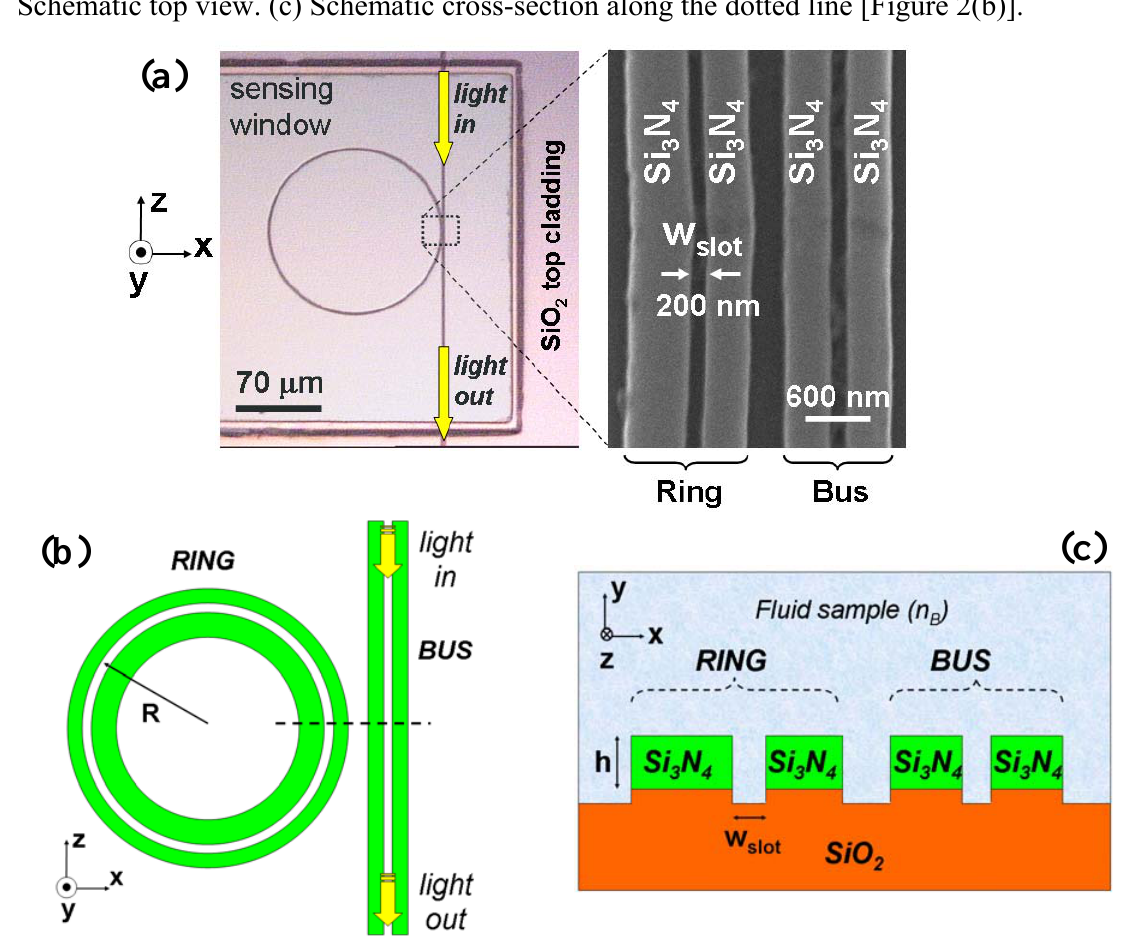
Figure 2. (a) Left: Top view photograph of a 70- μ m-radius Si microring resonator. Right: Scanning electron microscope image of the coupling region. (b) Schematic top view. (c) Schematic cross-section along the dotted line [Figure